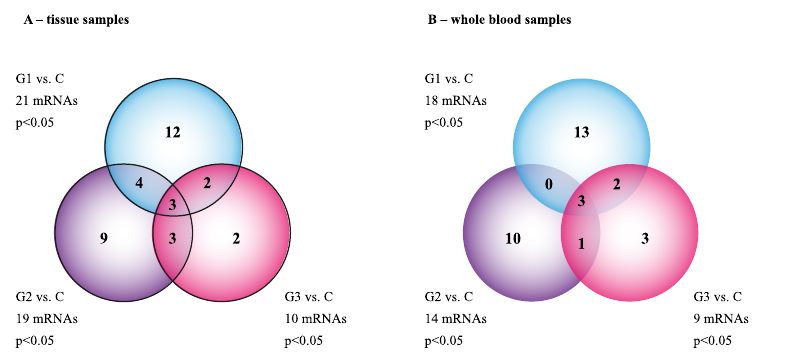
Figure 1. The Venn diagram of microarray results ( p < 0.05). ( A )—Tissue samples; ( B )—whole blood samples.